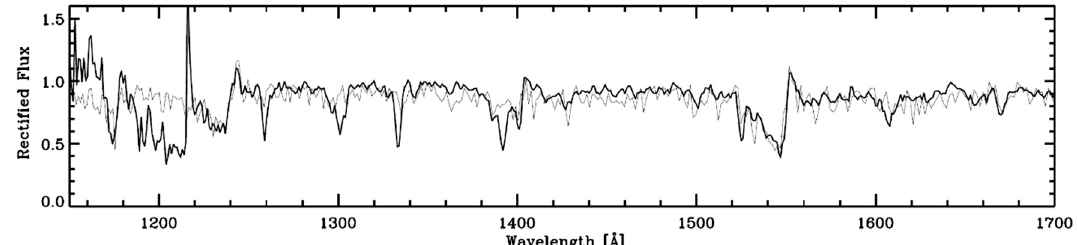
Figure 12. Comparison of the average spectrum of the 46 local star-forming regions shown in Figure 8 (dark spectrum) and a simulated spectrum following a Salpeter IMF with stars up to 100 M ⊙ (light spectrum). Models and data of the wind features of N V 1240, Si IV 1400, and C IV 1550 are in excellent agreement. The narrow absorption features (e.g., at 1260 Å, 1335 Å, and blended with the Si IV 1400 P Cygni profile) are interstellar and are not modeled in the synthetic spectrum. From [55].